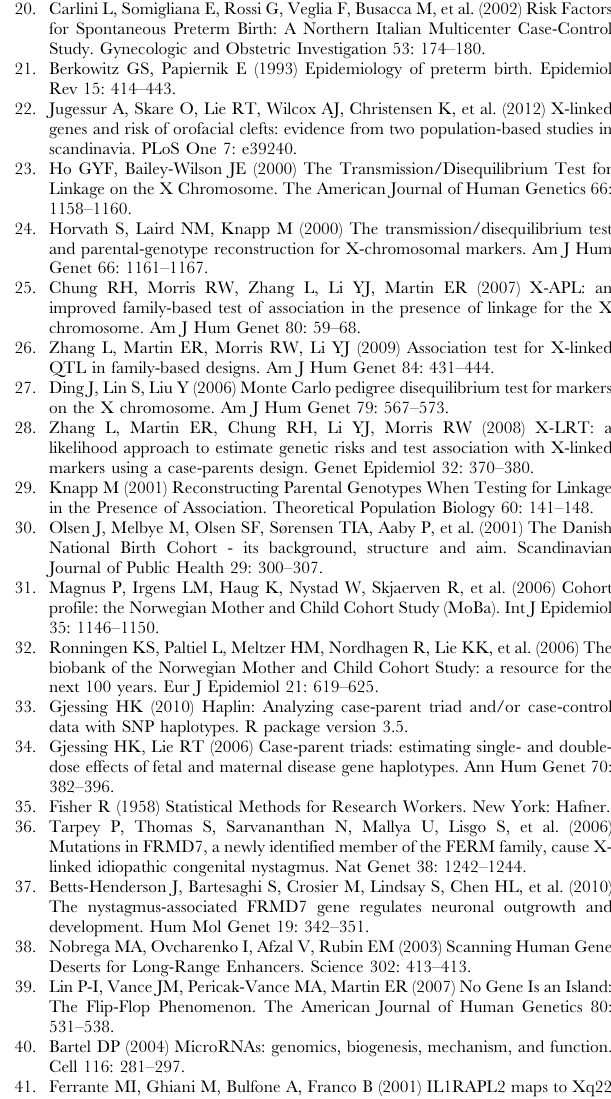
Table S4 Sex-stratified analysis, females, p , 1.00 6 10 2 3